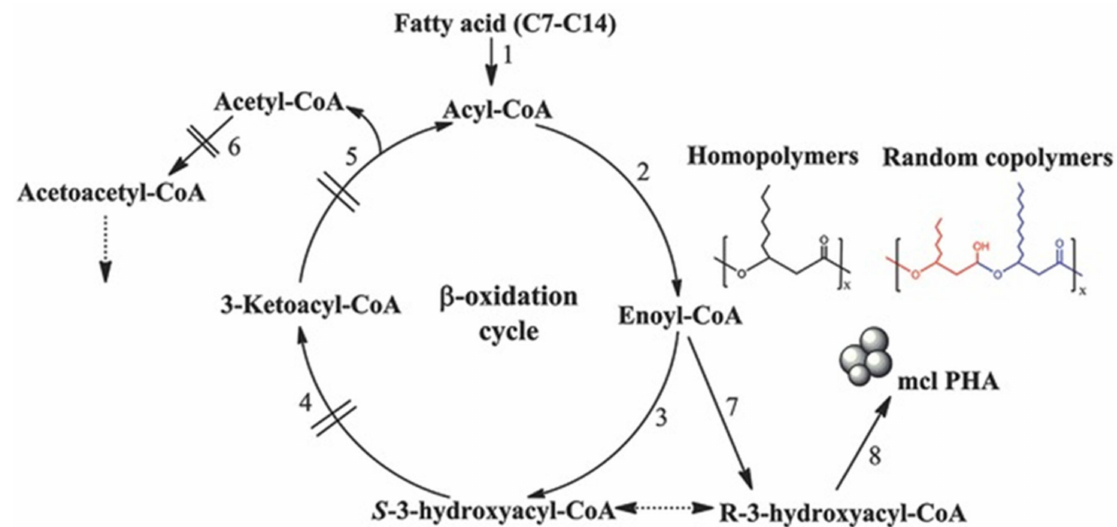
Figure 4. Production of mcl-PHA homopolymers by the β -oxidation of impaired Pseudomonas entomophila LAC23. Repro- duced with permission from [55]. Copyright 2017 John Wiley & Sons,